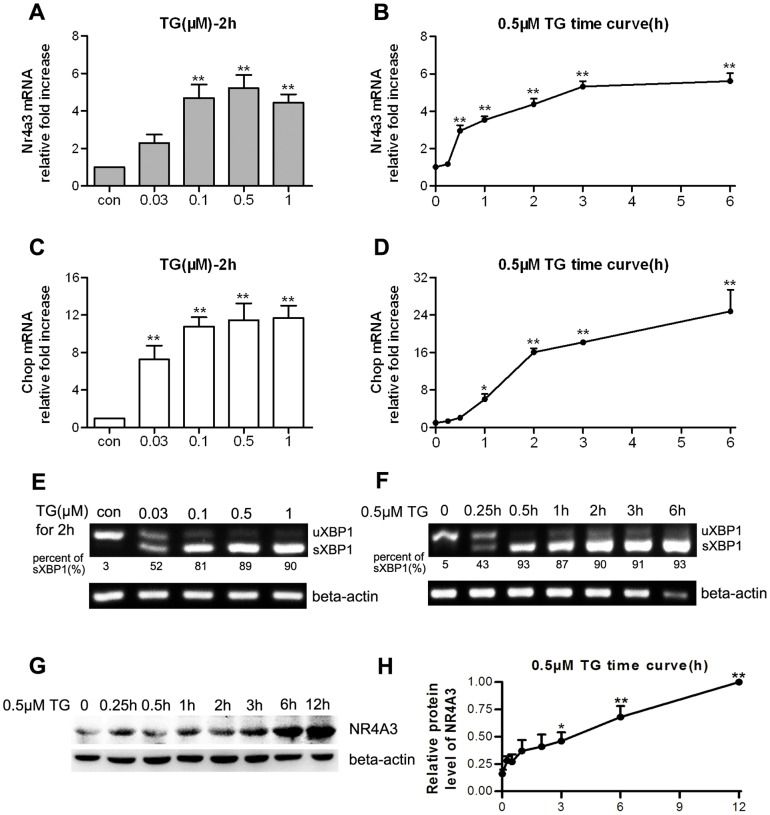
Thapsigargin (TG) treatment induced NR4A3 expression and unfolded protein response (UPR) activation in MIN6 cells.(A, B) NR4A3 mRNA levels in response to (A) different doses of TG and (B) a fixed TG dose at a series of time points. (C, D) Chop mRNA levels in response to (C) different doses of TG and (D) a fixed TG dose at a series of time points. Relative mRNA levels of NR4A3 and Chop were determined with real-time quantitative PCR. (E, F) Spliced XBP1 (sXBP1) mRNA formation in response to (E) different doses of TG and (F) a fixed TG dose at different time points. Two forms of XBP1 (a UPR molecule) were detected with reverse transcription PCR. (G) NR4A3 protein profile in response to a fixed TG dose at a series of time points assayed with western blotting. (H) Semi-quantitative analyses of NR4A3 protein in response to a fixed TG dose at a series of time points. Data are shown as mean ± S.E. (n = 4). * p<0.05, ** p<0.01 vs. con (the dissolvent [DMSO] control group) or 0 h (baseline).